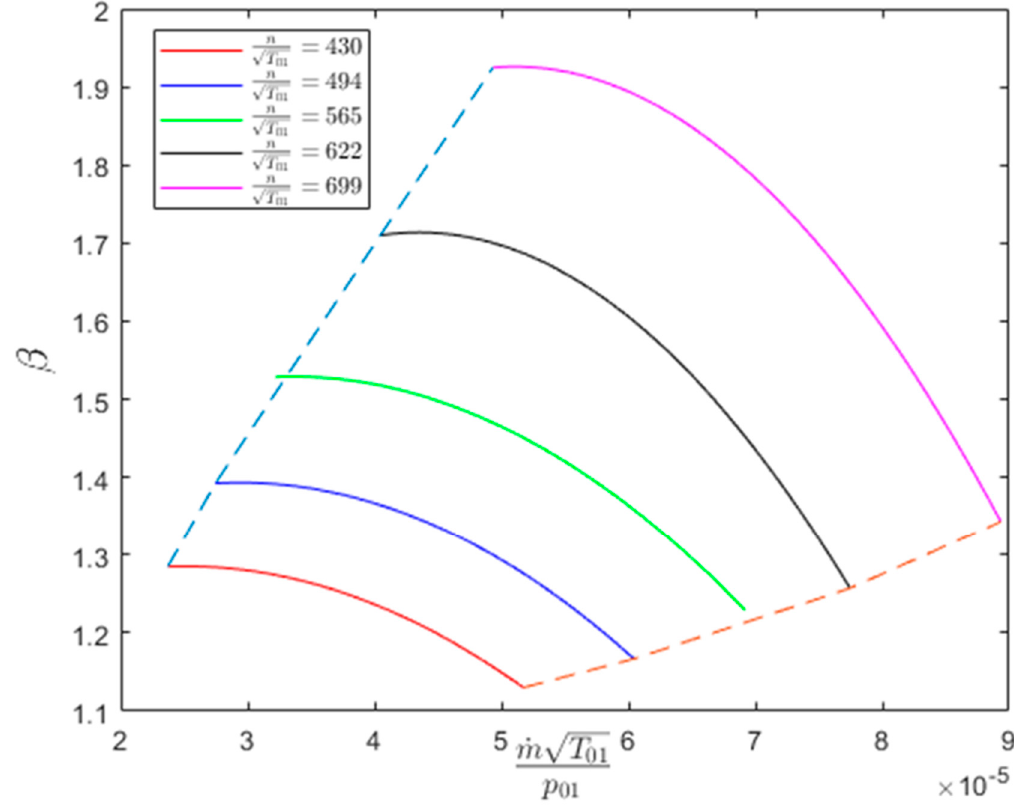
Figure 3. Compressor characteristic curves.